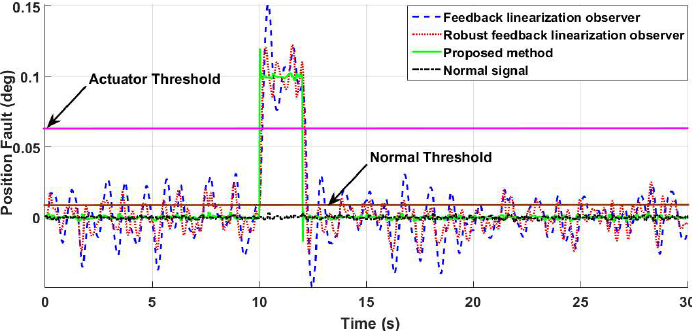
Figure 11. Fault detection for the fuzzy ARX-Laguerre feedback linearization method, the fuzzy ARX-Laguerre robust feedback linearization method, and the fuzzy ARX-Laguerre T–S fuzzy robust feedback linearization method for the surgical robot for the sinus.